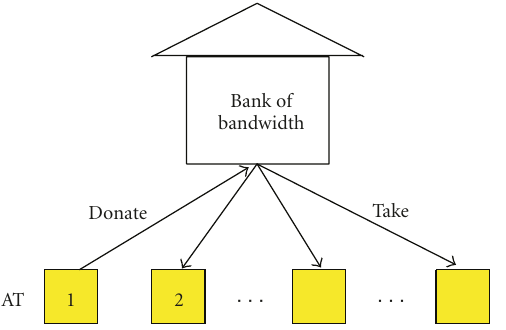
Figure 2: An illustration of the bank of